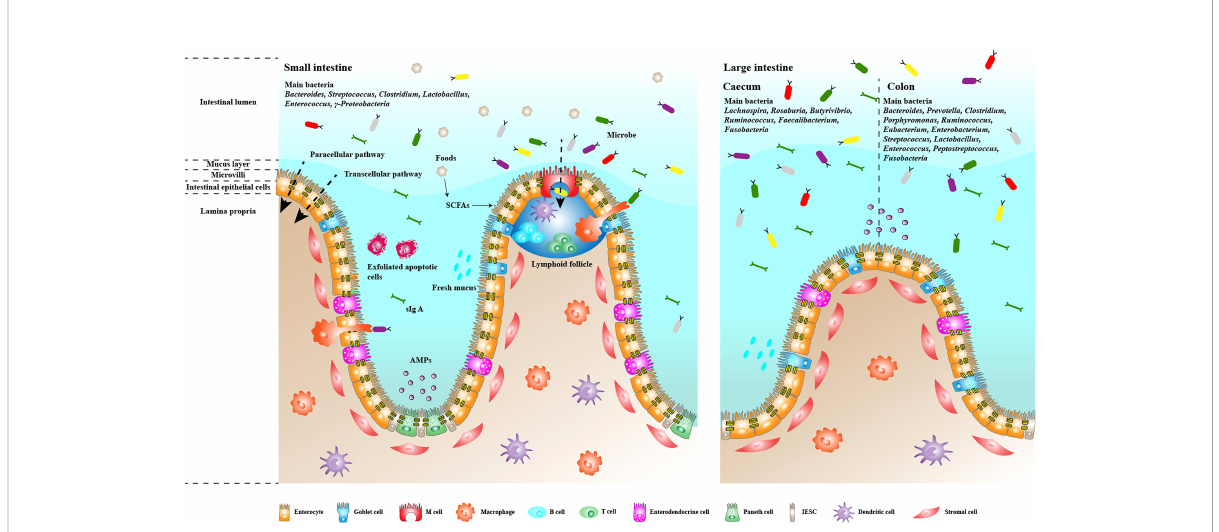
FIGURE 2 Composition and function of the intestinal mucosal barrier. The intestinal mucosal barrier has multiple mechanisms that help regulate intestinal homeostasis and prevent the invasion of pathogenic microorganisms and their metabolites in the intestinal lumen. Single layers of epithelial cells are bound together by apical junctions, constituting the most basic and essential barrier. The barrier regulates the transport of bacteria and antigens through the paracellular and transcellular pathways. Parts of epithelial cells, such as Goblet cells and Paneth cells, can secrete mucins and antimicrobial peptides to form the mucus layer and prevent the excessive growth and invasion of fl ora. M cells continuously take up intestinal antigens and induce subsequent mucosal immune responses. Plasma cells in the lamina propria secrete IgA into the intestine to form an immune barrier that prevents bacterial